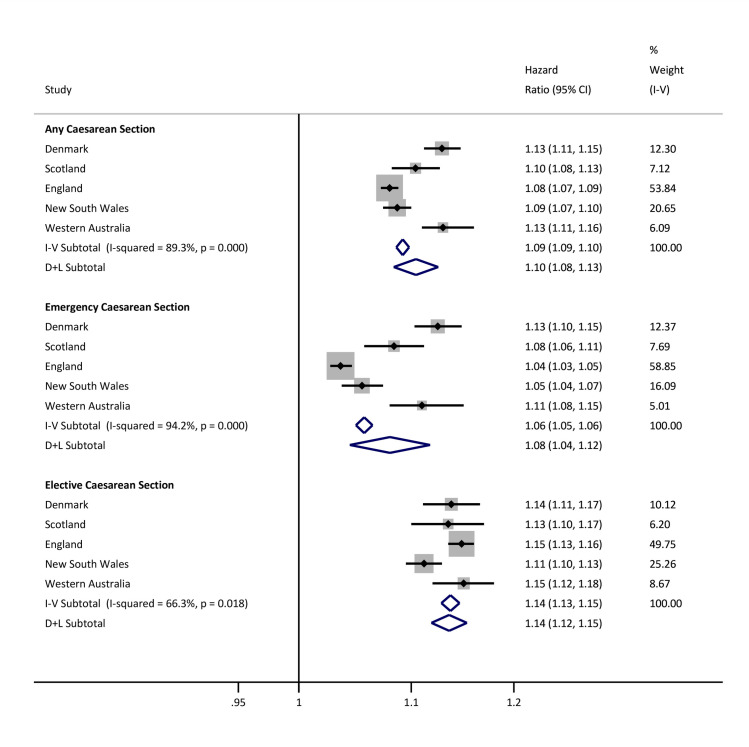
Site-specific and meta-analysis HRs for infection-related hospitalisations in children born to a low-risk population of mothers.Estimates are from recurrent events models fitted for total time. Models adjusted for sex, gestational age, birth weight z-score, smoking during pregnancy, maternal age at birth, parity, area level deprivation, birth year, medical indication for type of delivery, and season of birth. Reference is vaginal births. Low-risk population of births defined as cephalic presenting infants born ≥37 weeks gestational age, with birth weight between the 10th and 90th percentiles for gestational age and sex, born to women aged 20 to 34 years without any reported medical conditions during pregnancy. CI, confidence interval; D+L, DerSimonian and Laird random effects model; HR, hazard ratio; I-V, inverse-variance weighted fixed effects model.